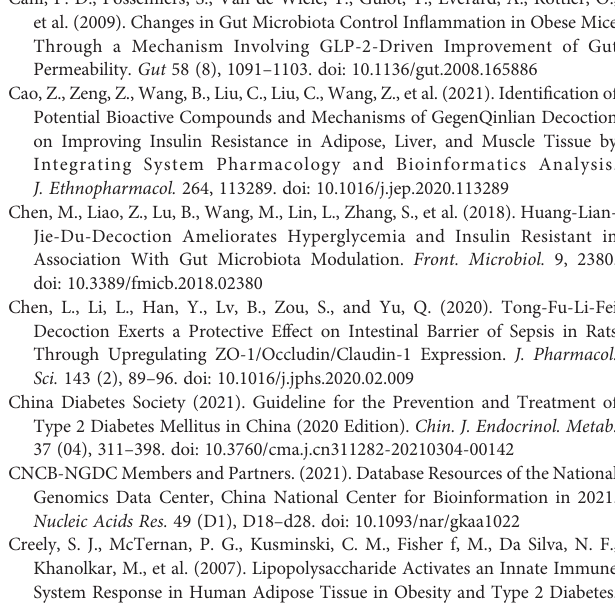
Supplementary Figure 1 | Diversity of the gut microbiota among different groups. (A) Number of genera. (B) Shannon diversity. Supplementary Figure 2 | Comparisonofrelative abundance between (A) DM0w vs.DM12w; (B) GQD0wvs.GQD12w; (C) Met0wvs.Met12w; (D) DM12wvs.NC12w; (E) GQD12w vs. DM12w; (F) Met12w vs. DM12w; (G) GQD12w vs. Met12w. Supplementary Figure 3 | Comparison of gut microbiota structure among NC, GQD and